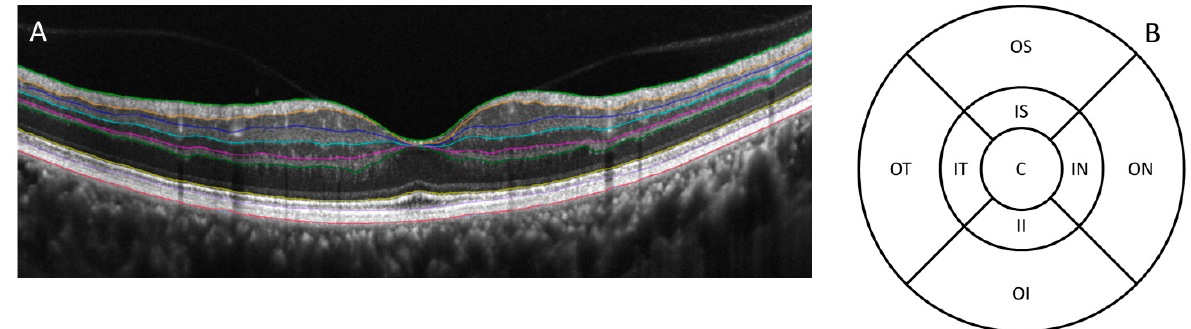
Figure 1. Example of the individual layer segmentation on a single B-scan (panel A ) and a schematic representation of the ETDRS sector map (panel B ). C: Central, IS: Inner Superior, OS: Outer Superior, IN: Inner Nasal, ON: Outer Nasal, II: Inner Inferior, OI: Outer Inferior, IT: Inner Temporal, OT: Outer Temporal.